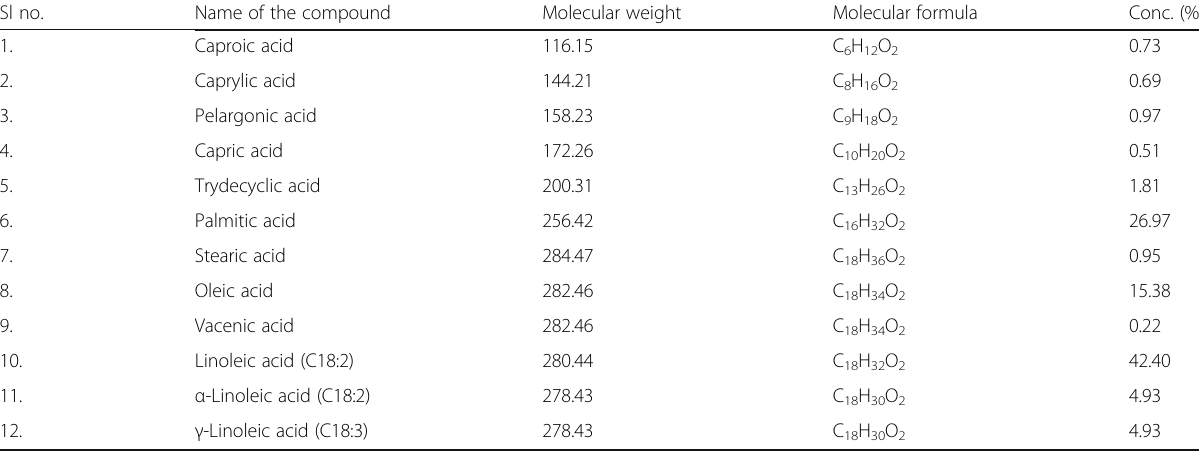
Table 5 GC-MS analysis of fatty acids of seeds of Cassia sophera Linn Sl